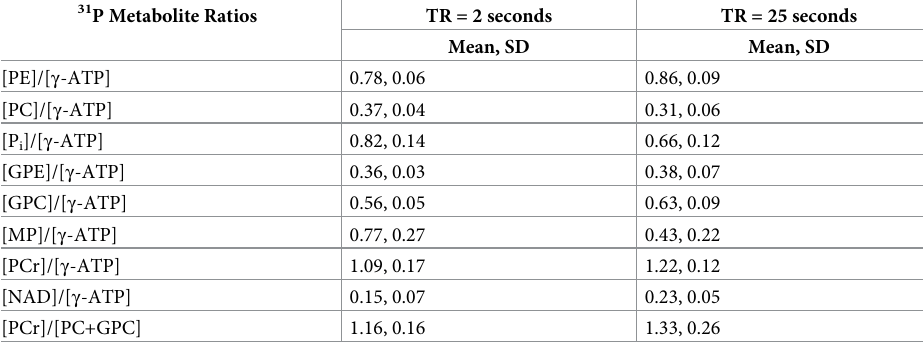
A Gaussian spectral model with freely adjustable linewidth was used to model